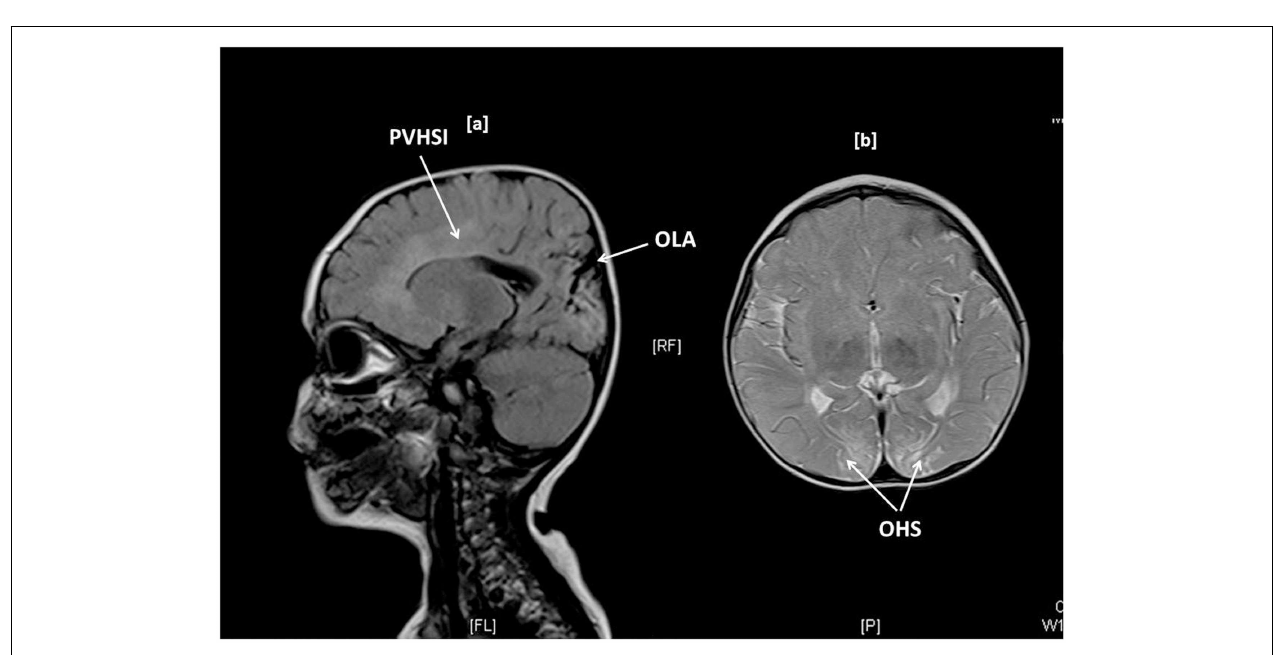
occipital hyperintense signals (OHS) within subcortical white matter in proton density andT2 axial images, the latter being highly suggestive of hypoglycemic injury.